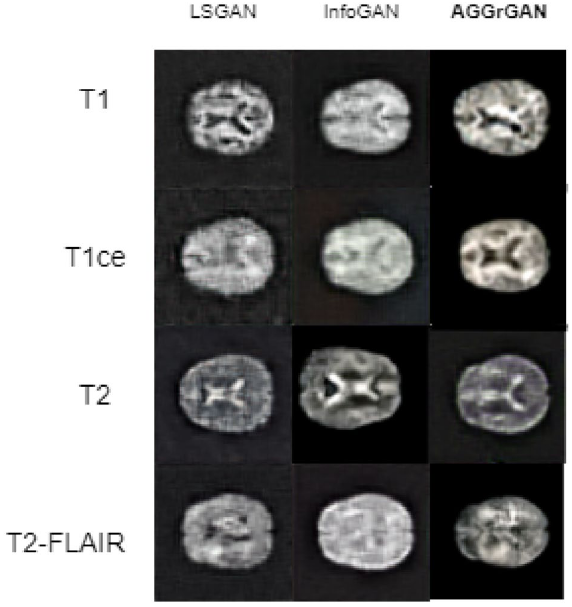
Figure 6. Visual comparison between sample generated images by existing GAN architectures like LSGAN, InfoGAN and the proposed AGGrGAN in the BraTS 2020 dataset 16 where each row represents images of the same class and each column represents images generated by the same method.